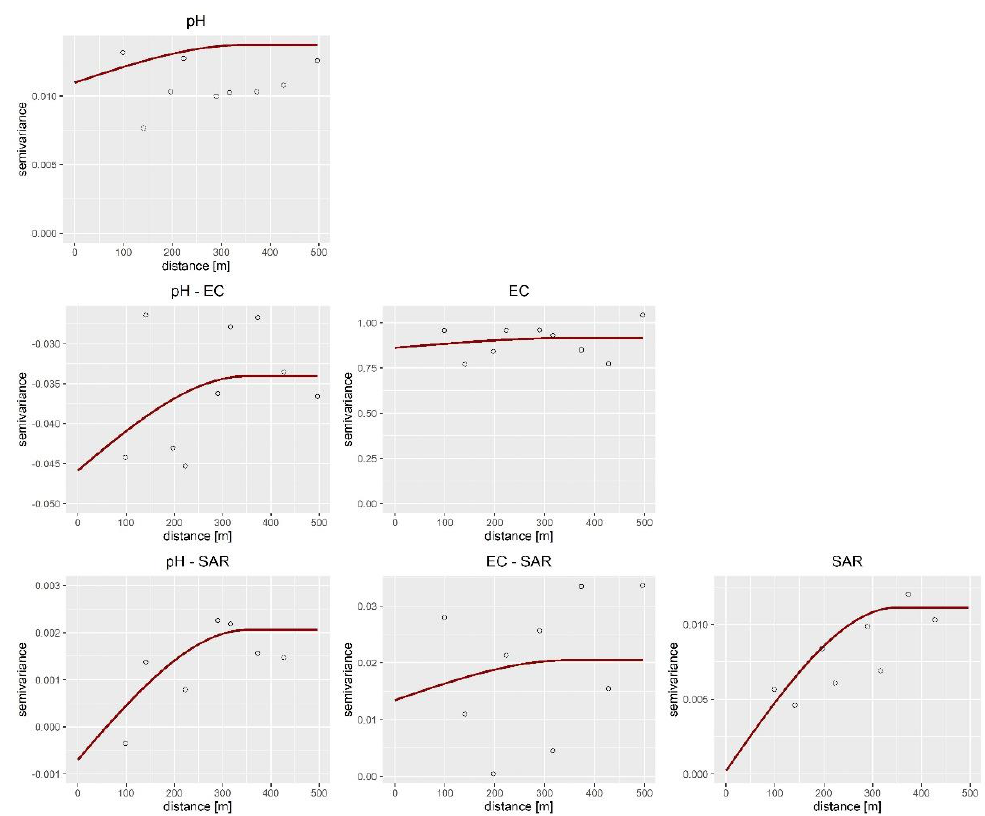
Figure 4. The computed direct and cross-variograms (open circles) and fitted linear model of coregionalization (solid line).